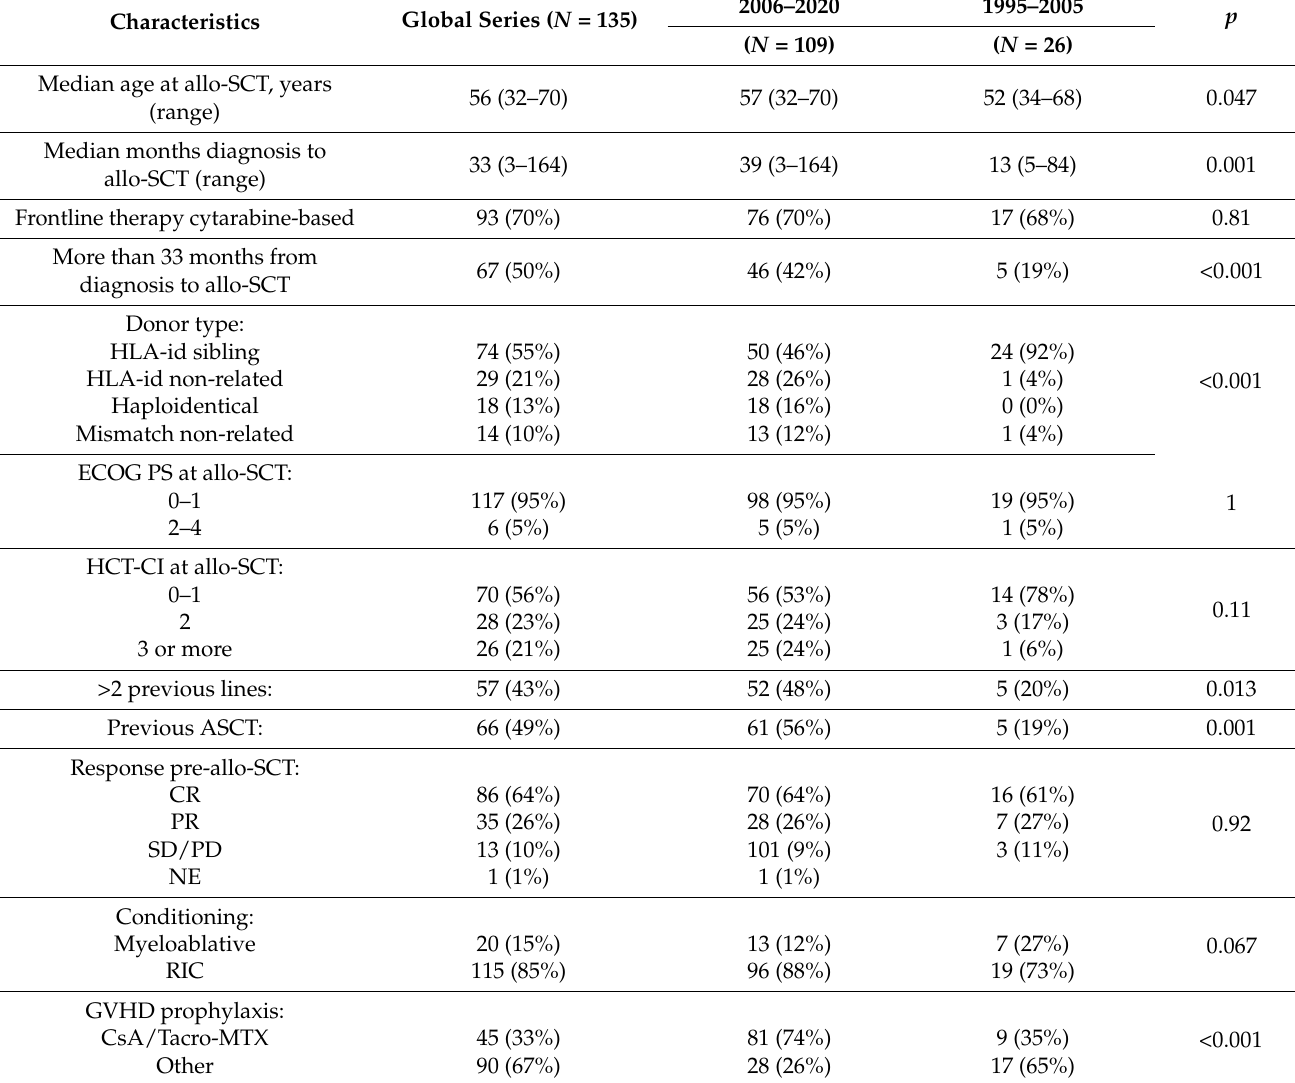
Table 4. Analysis of patient characteristics according to time